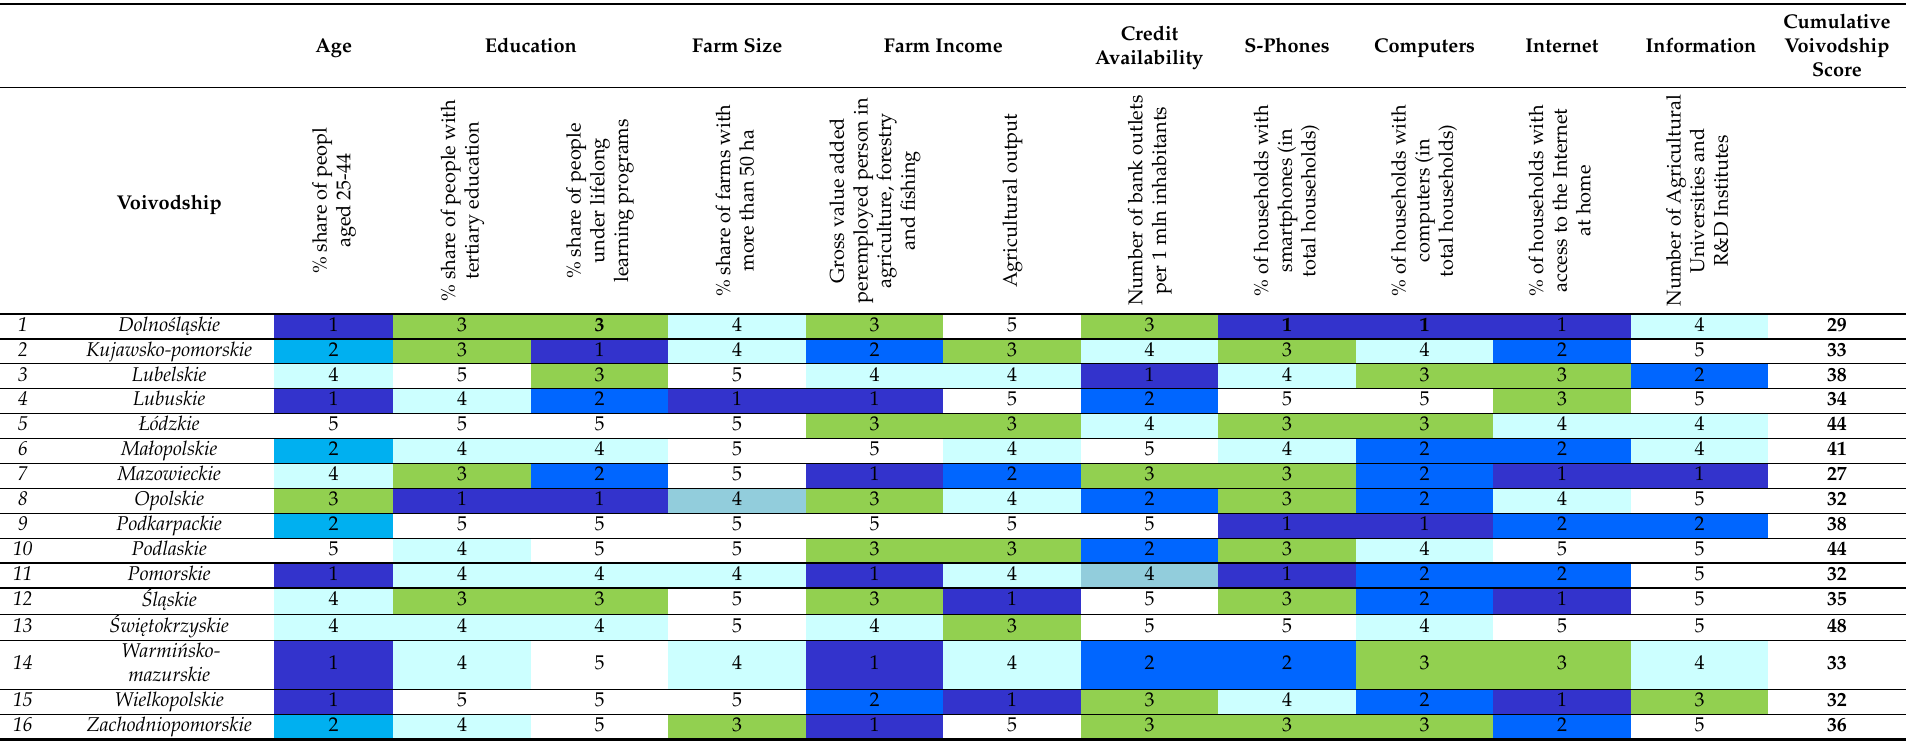
Table 15. PA adoption potential of 16 Polish voivodships ranked by 5 PA adoption clusters (1-highest adoption potential; 5-lowest adoption potential). Age Education Farm Size Farm Income